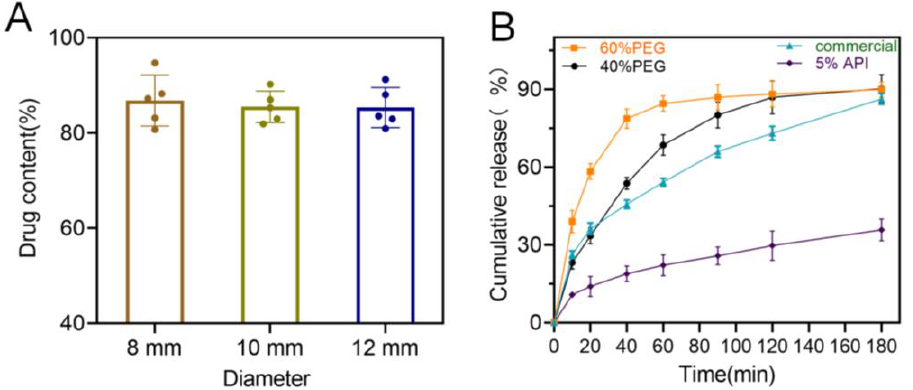
Figure 12. ( A ) Drug content of the 3D-printed bilayer oral films (n = 6); ( B ) in vitro drug cumulative